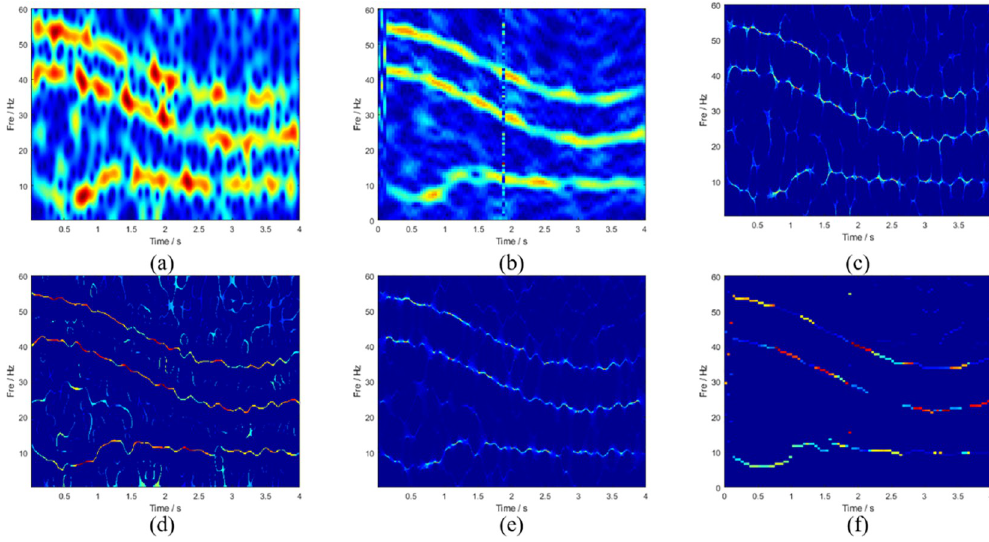
Fig 5. TFA results obtained through (a) STFT, (b) SBCT, (c) RM, (d) SET, (e) SST, and (f) LMSBCT.